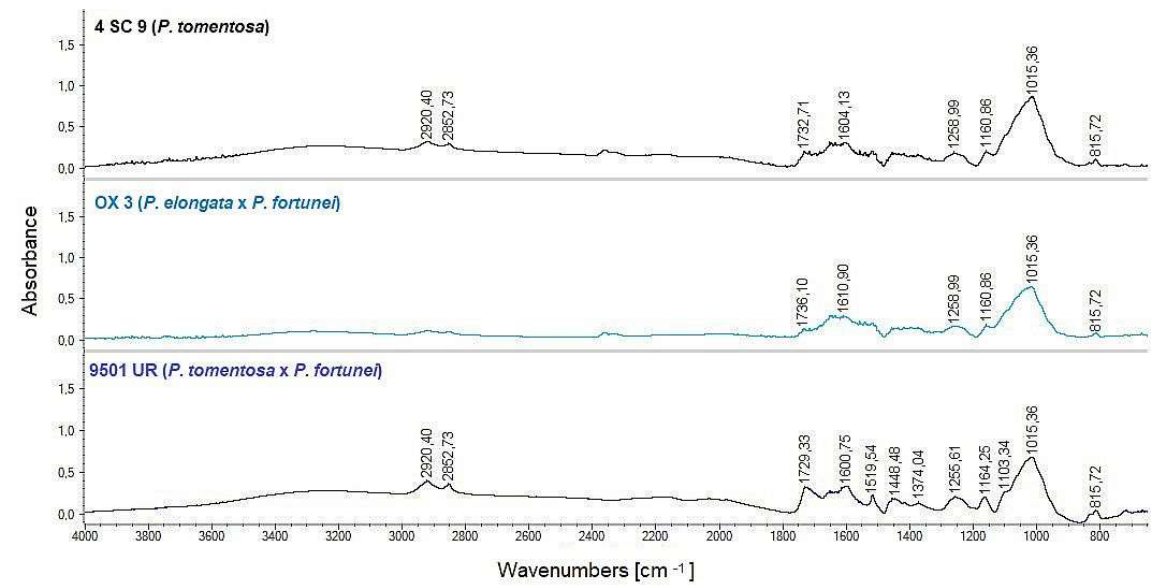
Figure 2. FT-IR spectra of powdered leaves for selected representatives of individual clones.